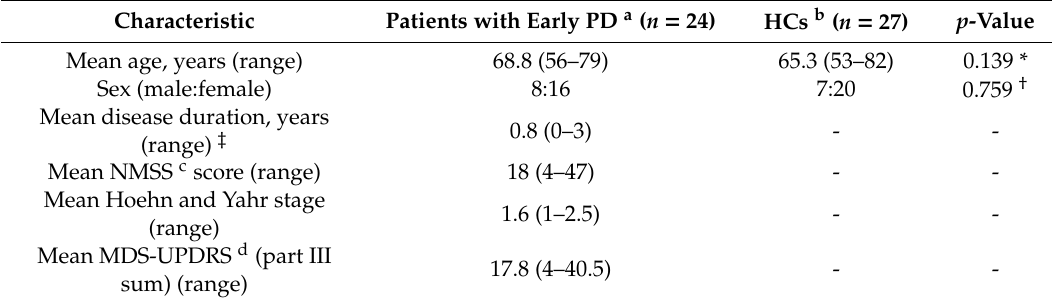
Table 1. Demographic and clinical characteristics of the study